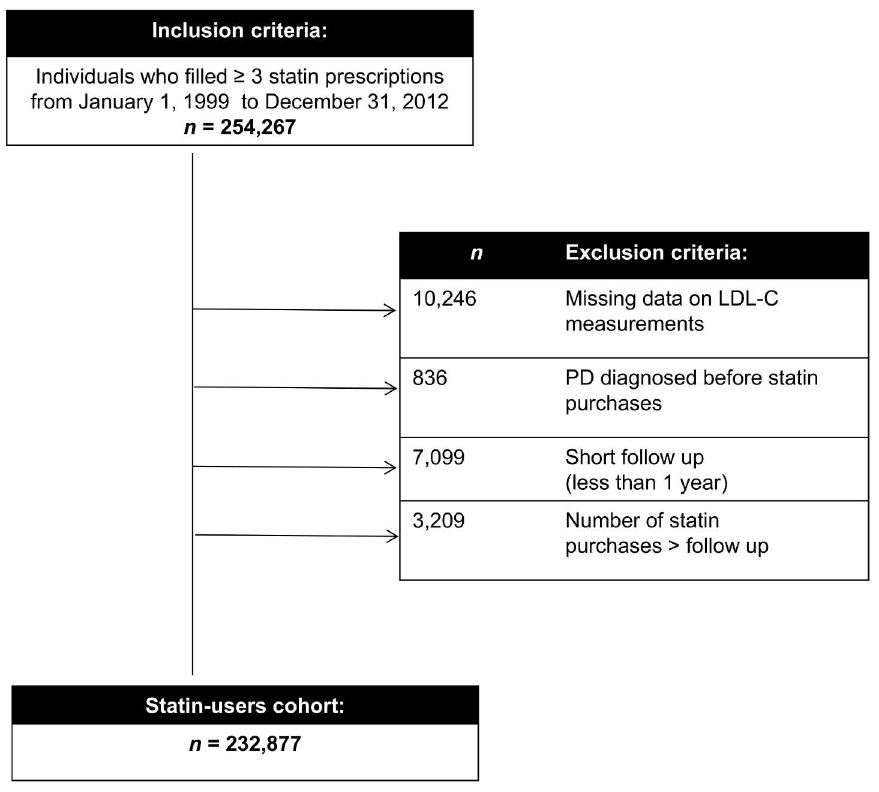
Fig 1. Inclusion and exclusion criteria to establish the statin-users